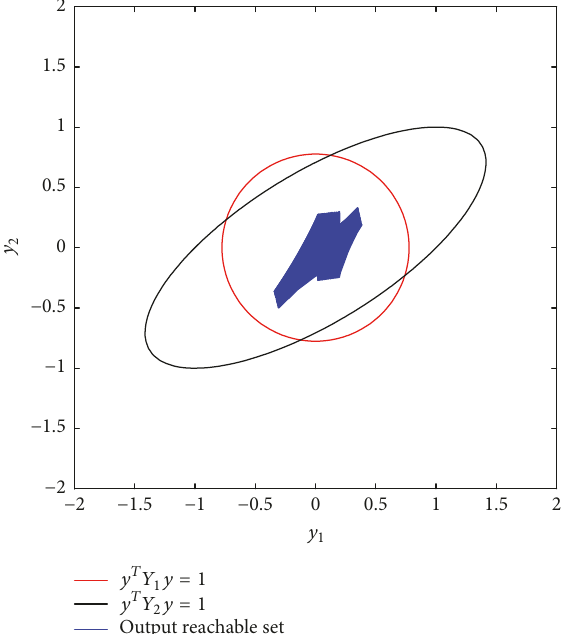
Figure 3: The output reachable set R 𝑦 and the bounding ellipsoids.